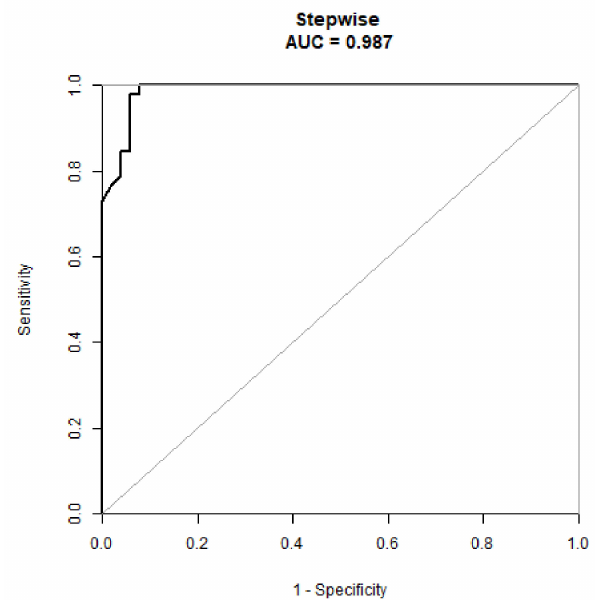
Figure 5. A receiver operating characteristic curve to evaluate the discriminating capability of the